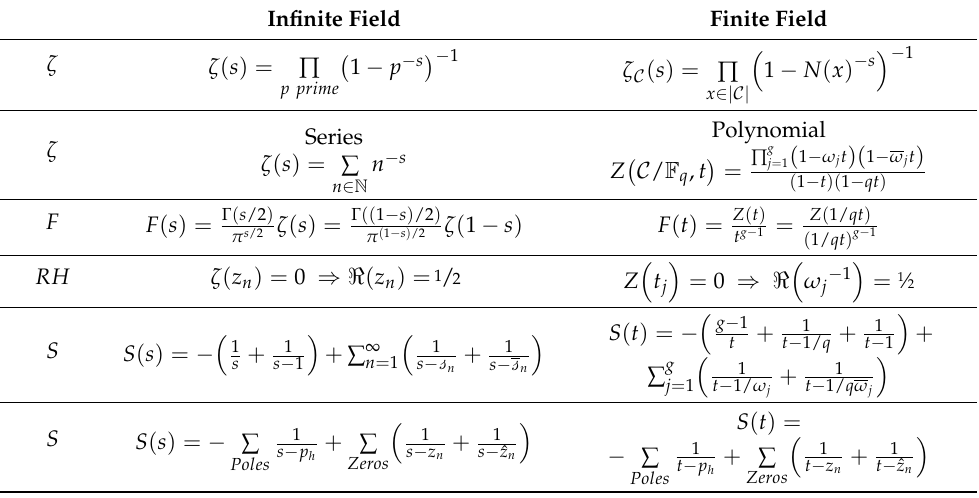
Table 5. Similarity between both fields. This table shows the corresponding expressions in both